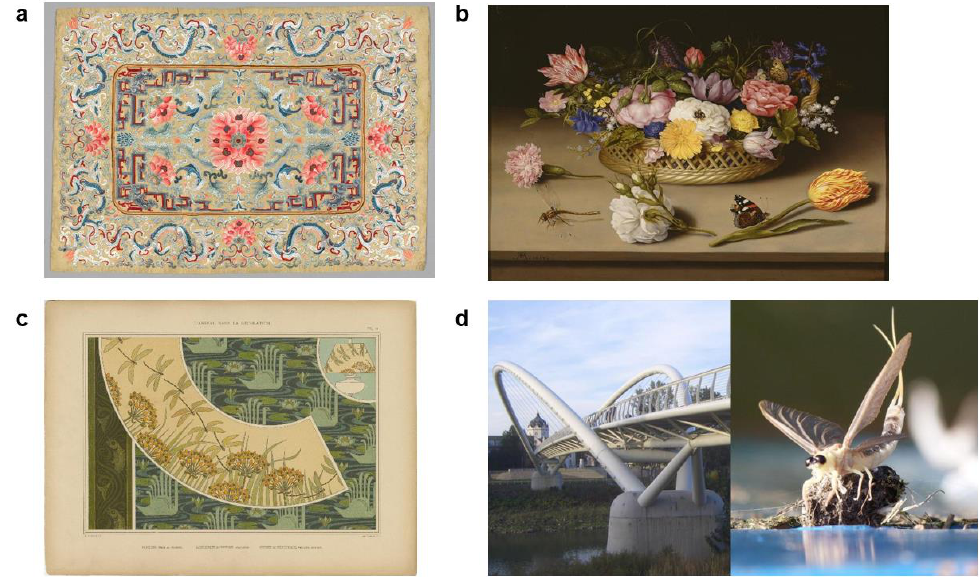
Figure 1. Cultural services provided by insects in the visual arts: ( a ) 19th-century Chinese embroi- dered silk (Cleveland Museum of Art: